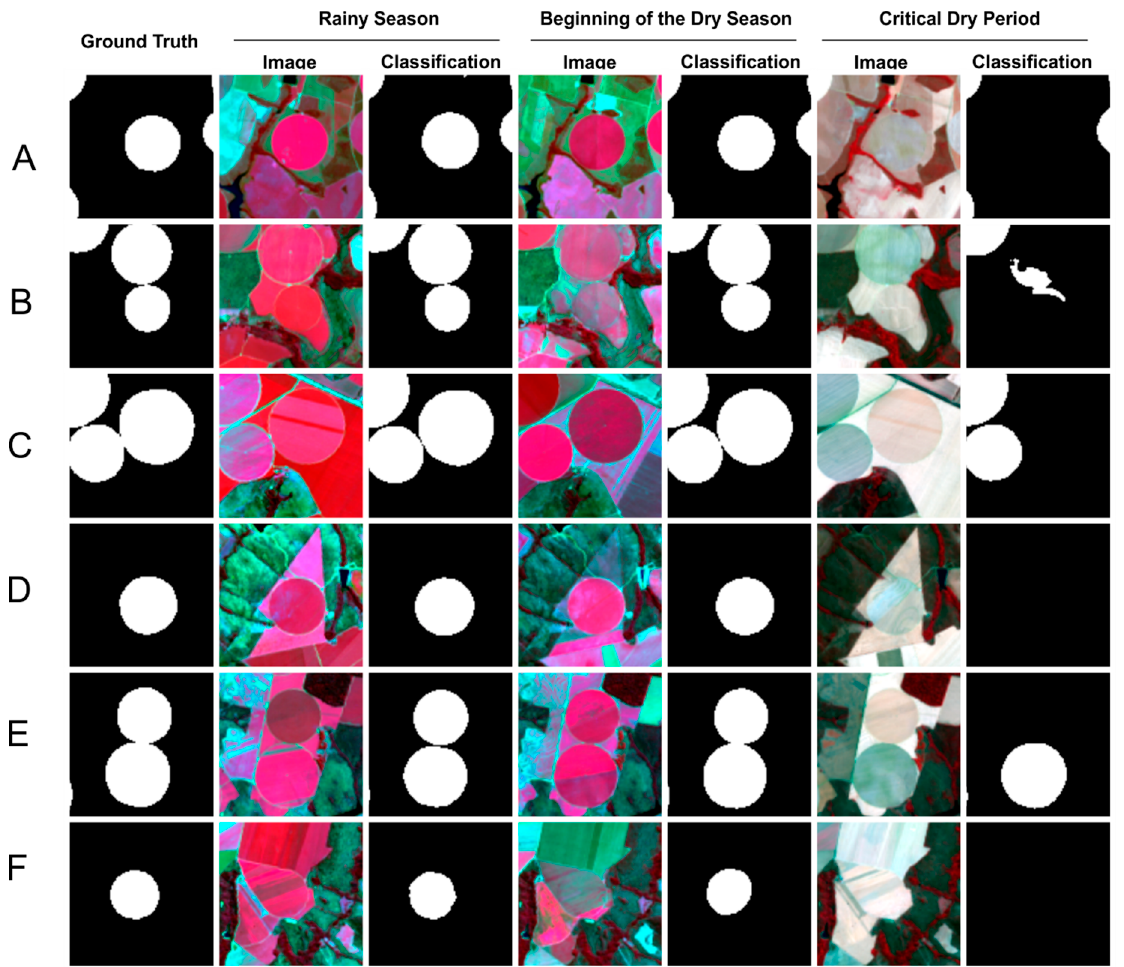
Figure 12. Comparison of zoomed areas ( A – F ) at di ff erent times of the year (rainy, early dry, and critical dry seasons). The examples demonstrate that the images from the rainy season and the beginning of the dry season detect the center pivots.